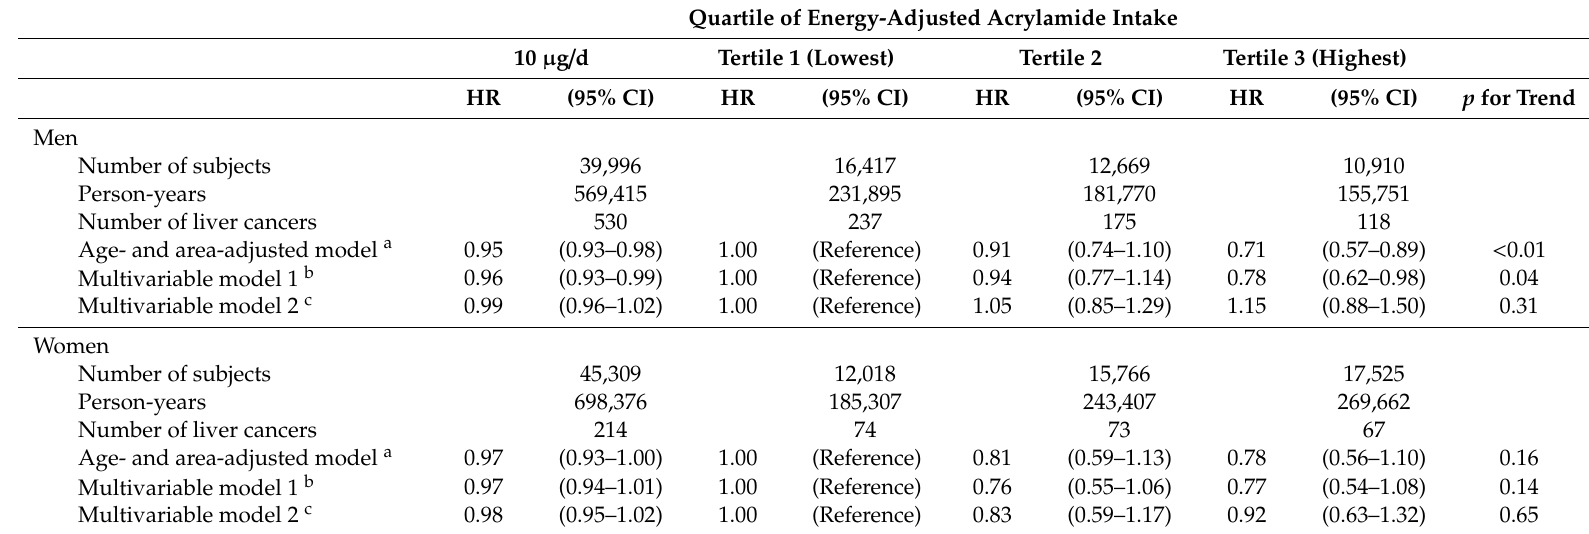
Table 3. Hazard ratios (95% confidence intervals) for liver cancer according to tertile of acrylamide intake by